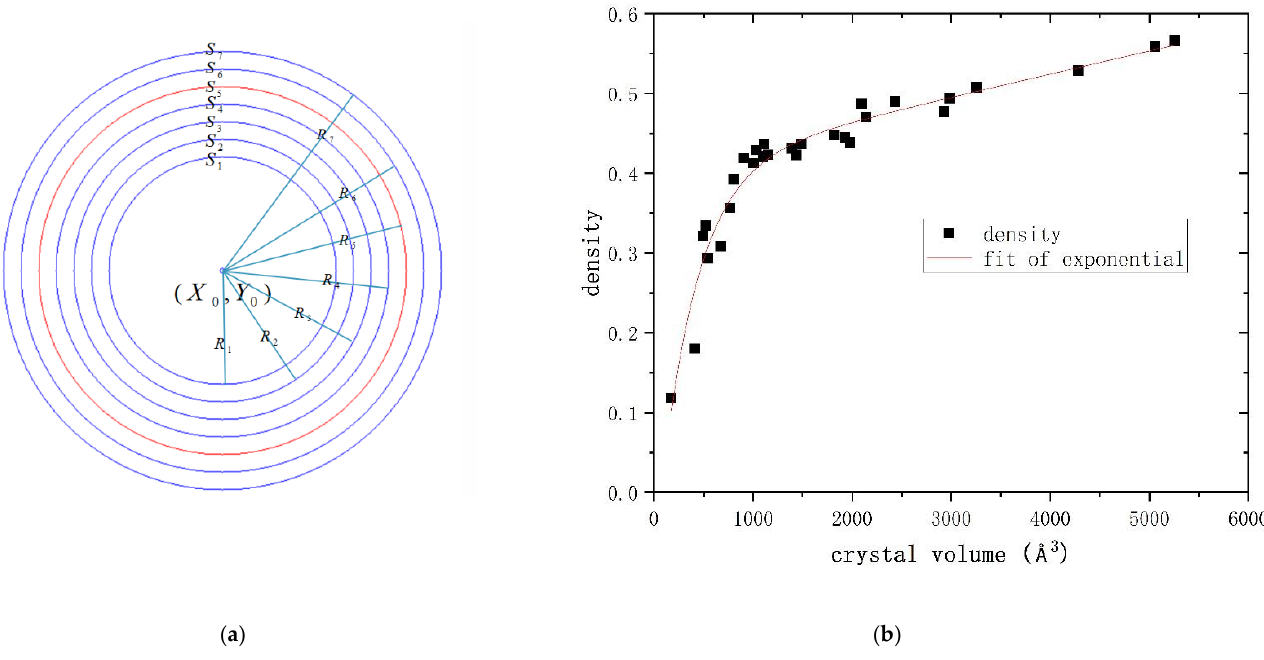
Figure 11. ( a ) Selection of correlation model D 5 for DCDP ratio calculation, and ( b ) relationship between lattice volume and Density by exponential fitting treatment.